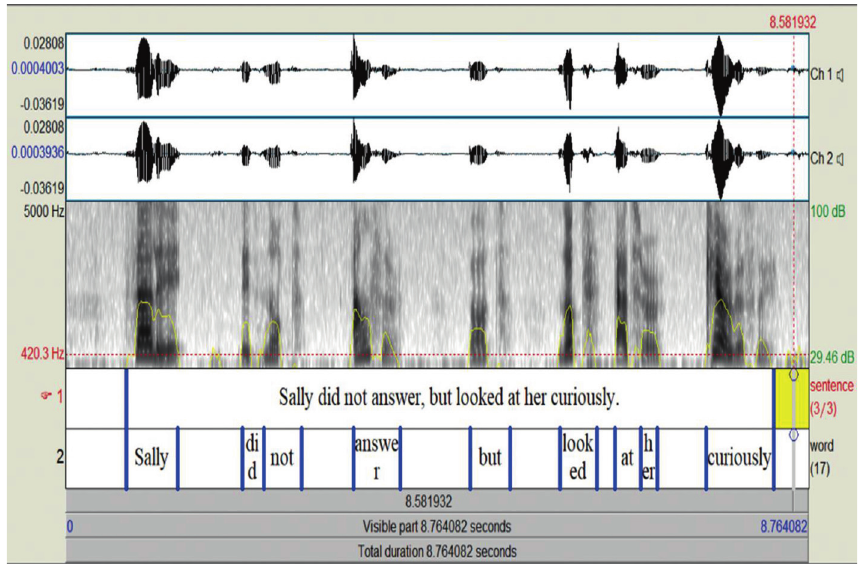
Figure 1: Spectrogram of sentence 3 from nonnative subjects.